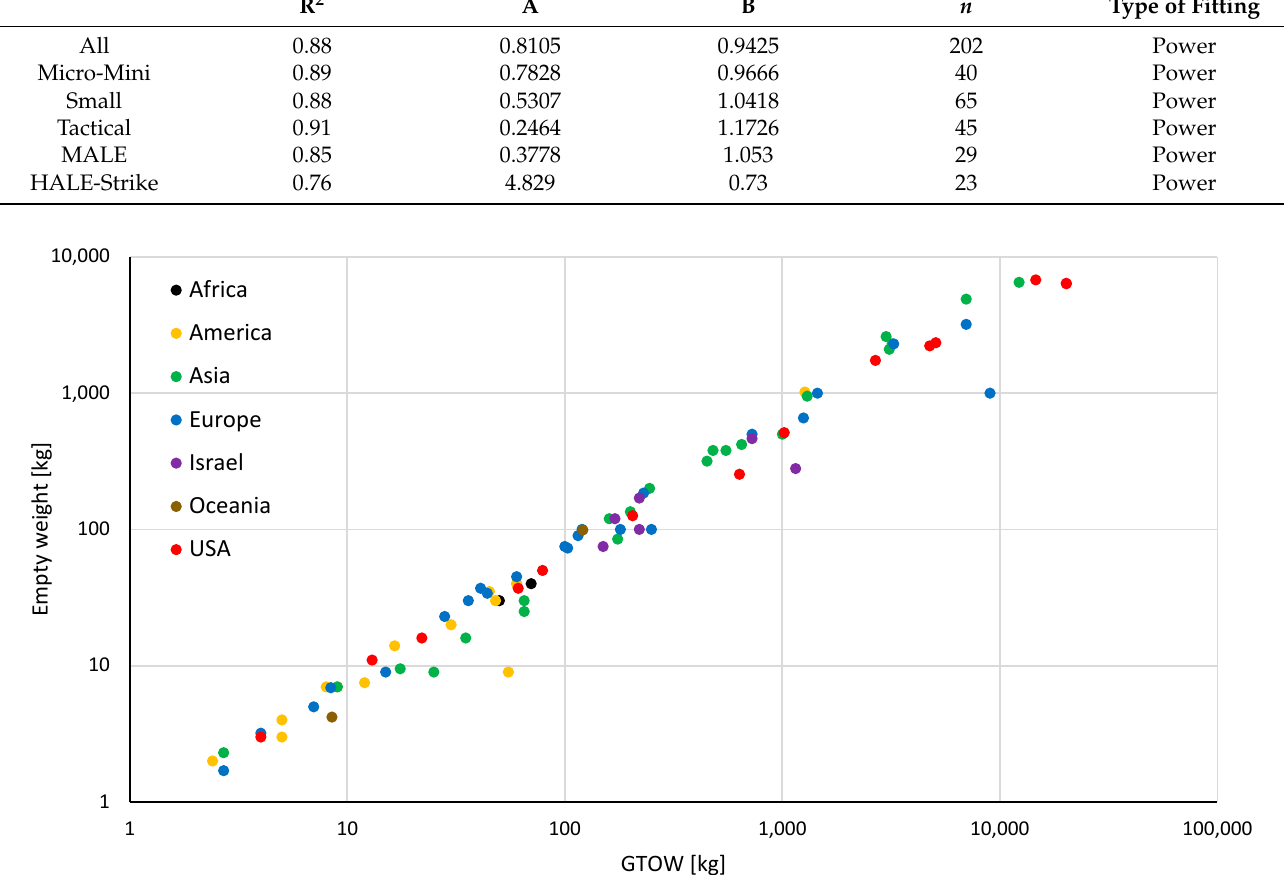
Figure 14. Empty weight divided by GTOW as a function of GTOW for the general category.